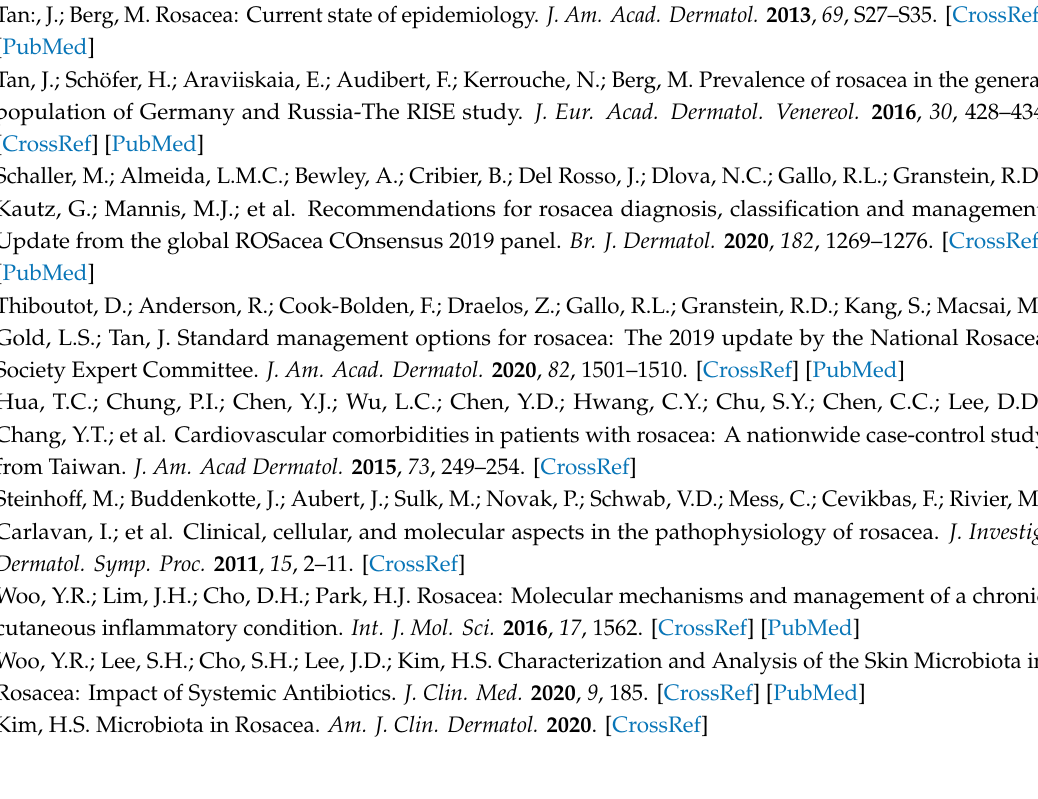
Table S1: The ICD-10 (International Classification of Disease, 10th revision, Clinical Modification) codes used for each disease